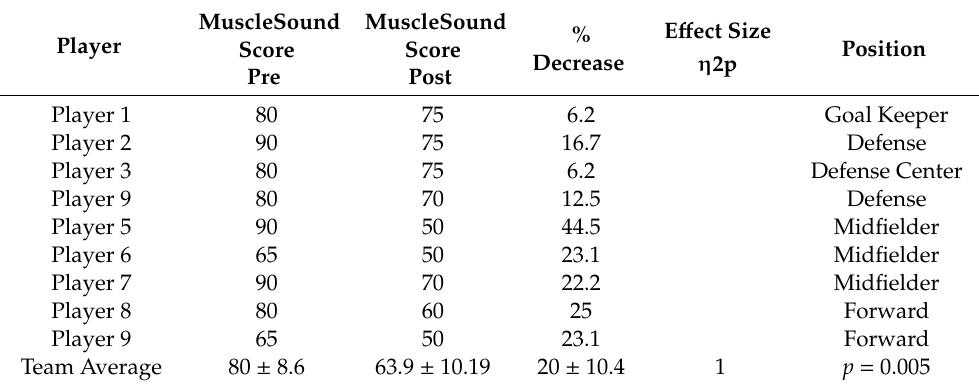
Table 2. Individual pre- and post-match rectus femoris glycogen content of each player and the position of each